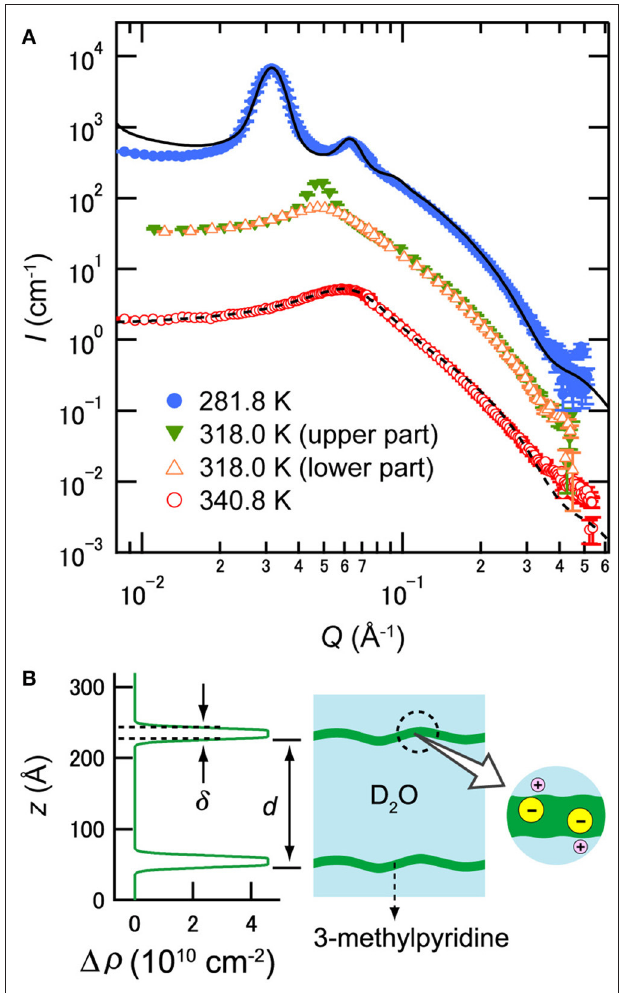
FIGURE 4 | (A) Temperature dependence of SANS profiles of D 2 O/3MP/NaBPh 4 mixture ( φ 3MP = 0.09 and C salt = 85 mmol/L). The data at lower temperatures have been multiplied by 10 for better visualization. The closed and open symbols indicate data for the lamellar phase and the sponge phase, respectively. The solid and dashed lines show the fitting result according to Equations (1) and (4), respectively. The data are taken from Sadakane et al. [24]. (B) Scattering density distribution at T = 283 K estimated from Equation (1) (left) and schematic picture of the distribution of ingredients (right). The z axis indicates the distance normal to the membrane. (B) is reproduced from Sadakane et al. [21] (Copyright 2009 by The American Physical Society). As per the copyright holder’s policies, no permission is required for the use of figures by the authors of the original article.